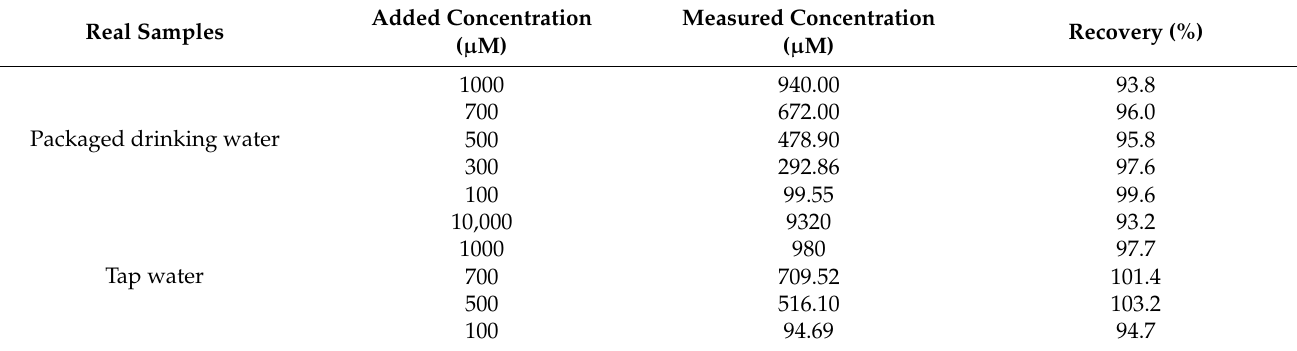
posites; Figure S2: XRD spectrum of nanocomposites; Figure S3: The DPV current response of PB-PEDOT/LSG/GCE at different cycles; Table S1: Electrochemical characteristics of different modi- fied